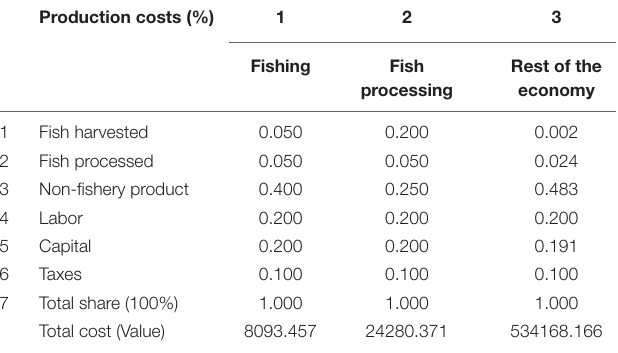
TABLE 1 | The macroeconomic data needed for the